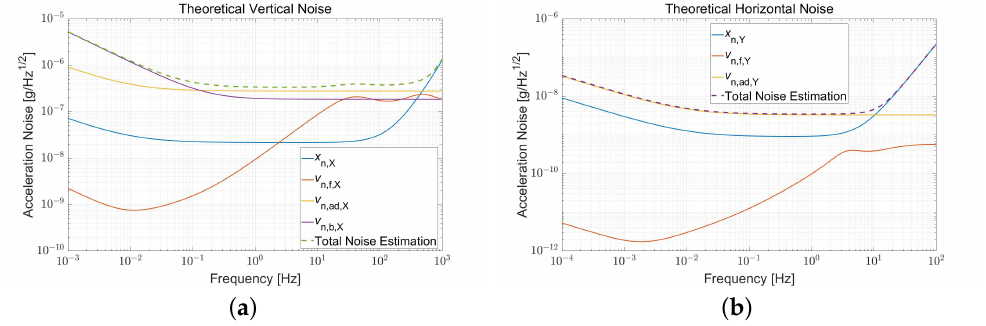
Figure 4. Theoretical noise estimation in ( a ) Vertical and ( b ) Horizontal directions, including the noise of the sensor circuit, HV amplifier circuit, and Readout system, which is the primary limitation of the total noise, are all converted to acceleration.